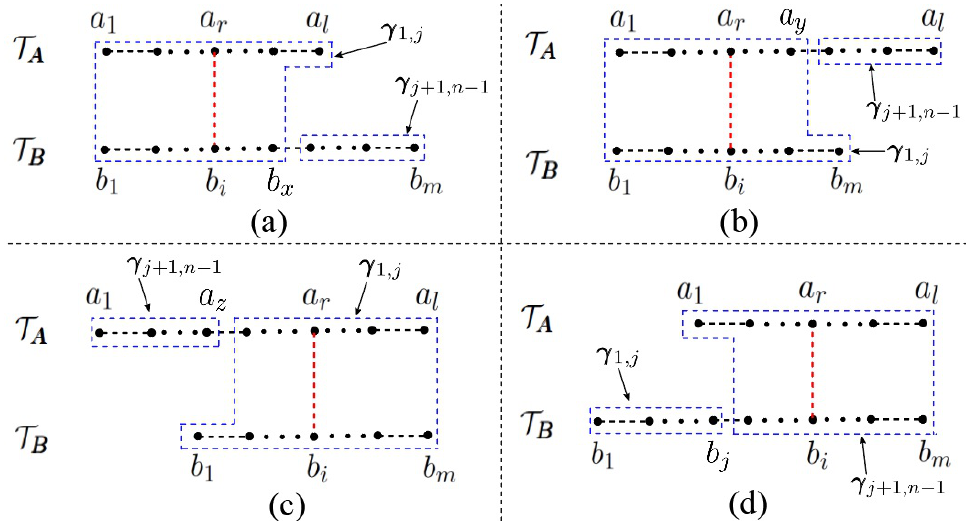
in (4.9) while the other boxed subgraph contributes 1 ,j